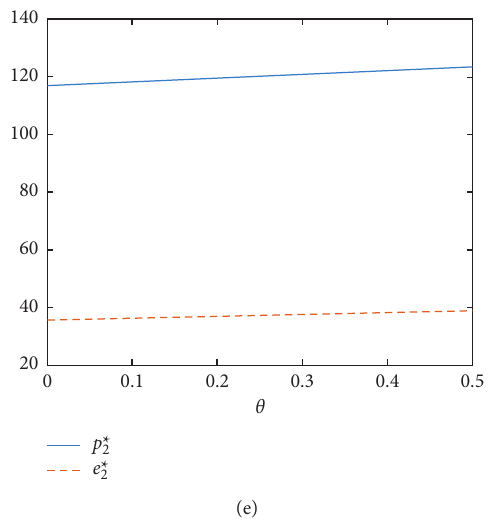
Figure 2: The impact of the provision of LS service on optimal